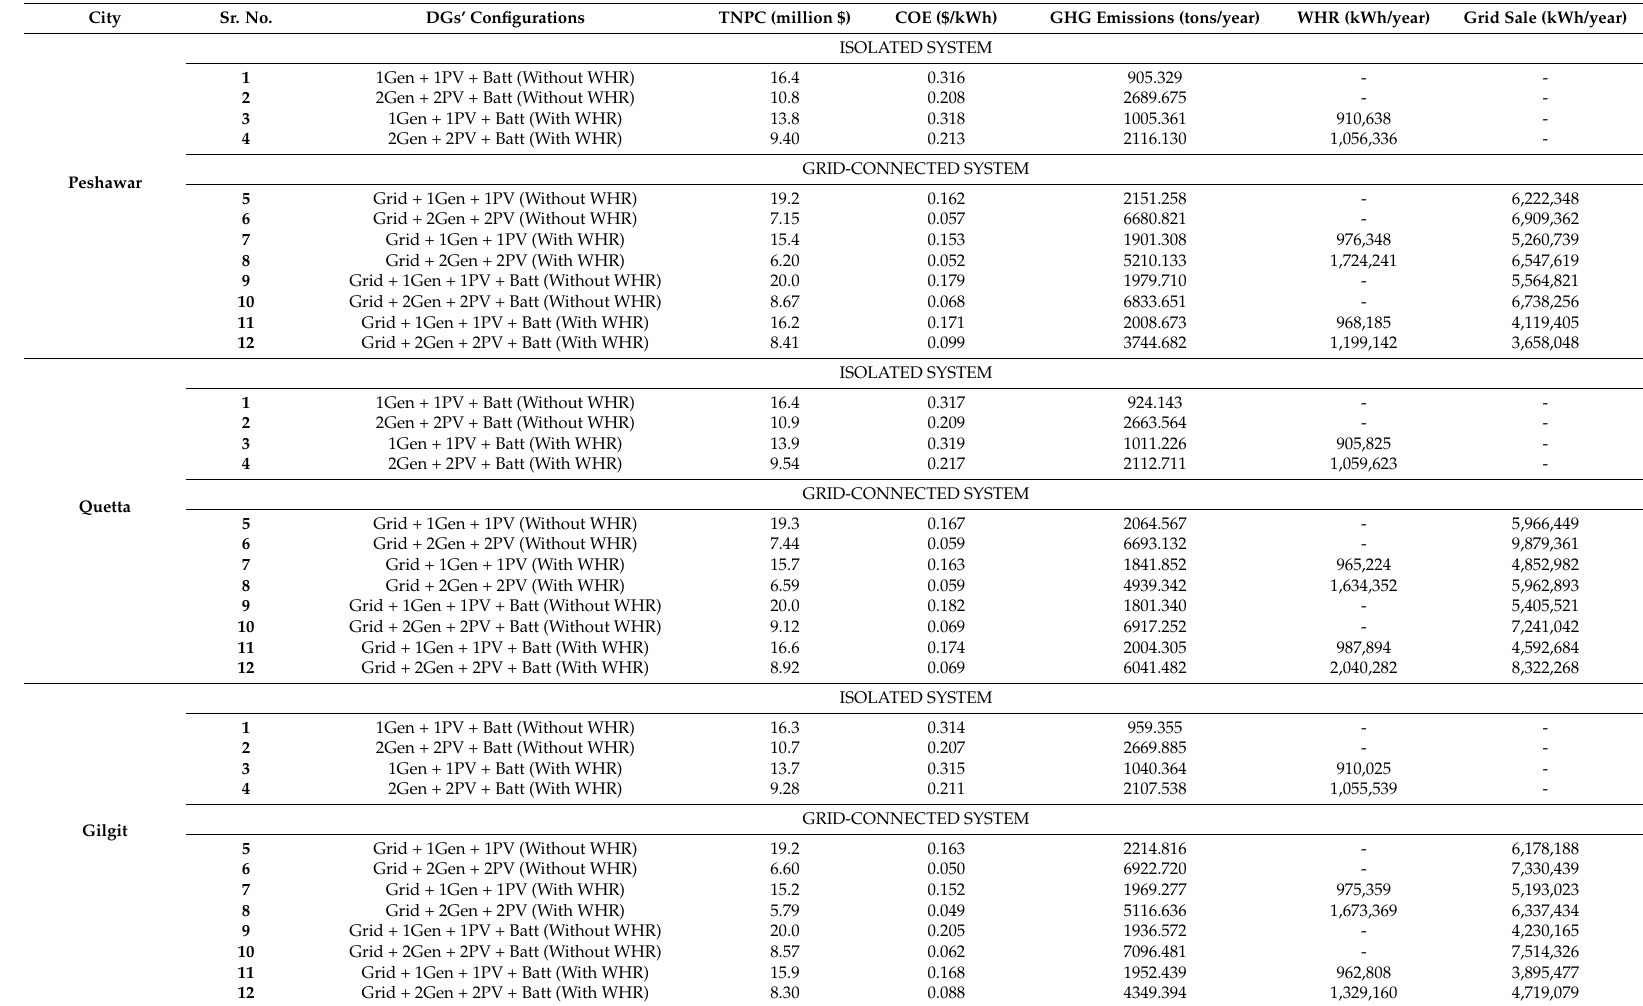
Table 7. Multiple objectives for Peshawar, Quetta and